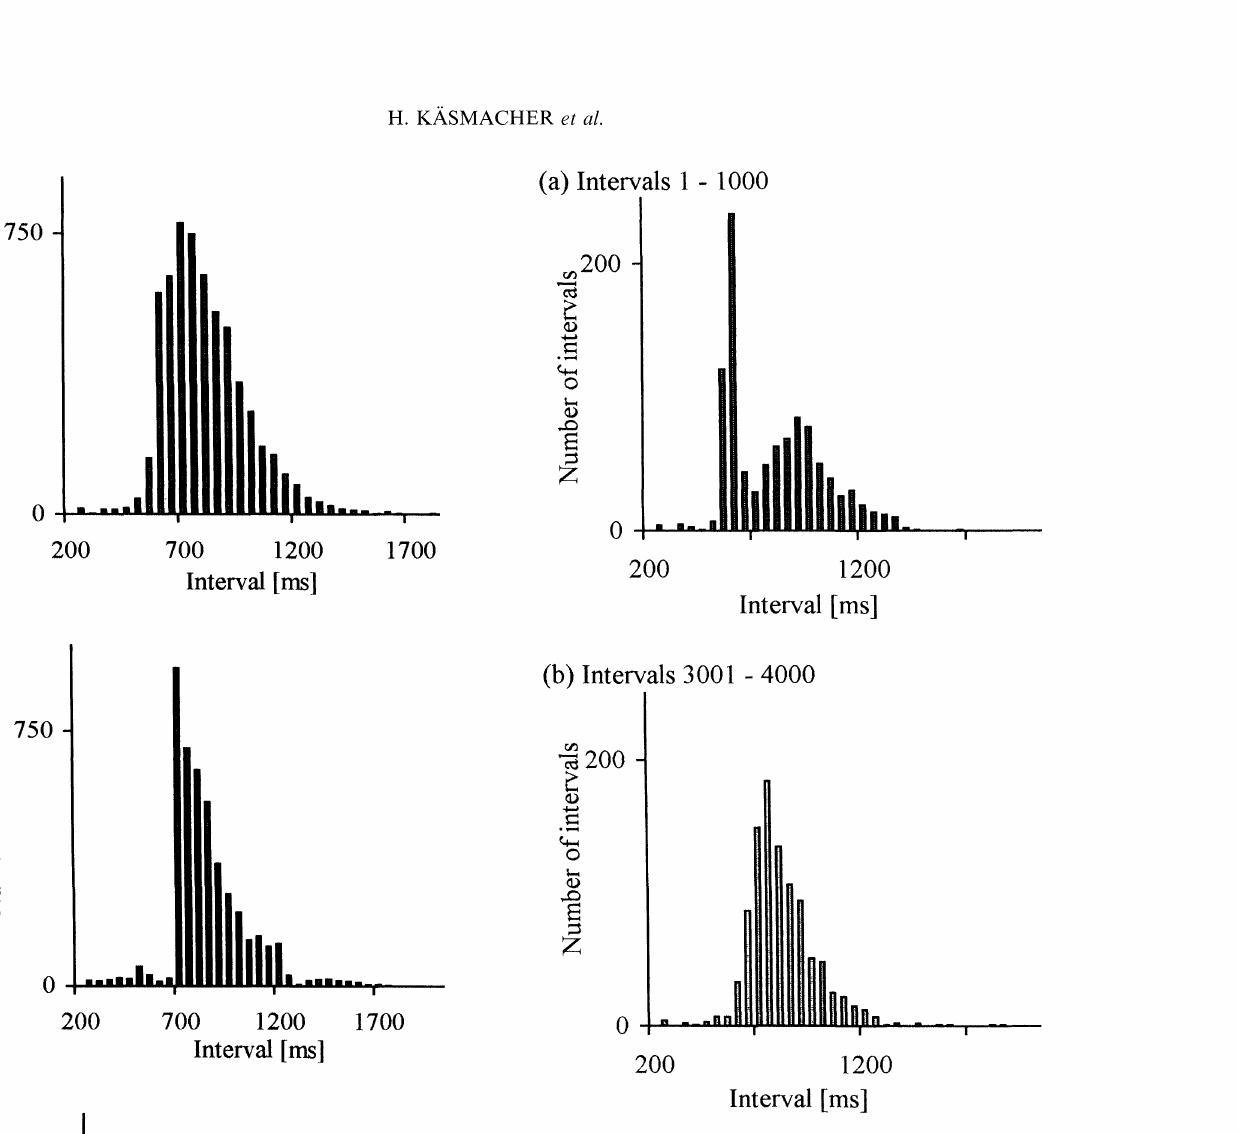
FIGURE 3 Shape of histogram of interval changes within a non-stationary registration: (a) depicts the histogram of inter- val lengths 1-1000 as bimodal, whereas in (b) the histogram of interval 3001-4000 is unimodal with a steeper left